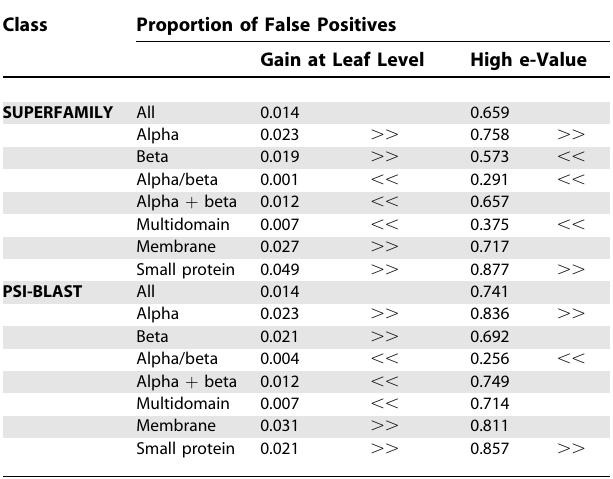
Table 2. Proportion of Predicted False Positive Assignments for Structural Classes Class Proportion of False